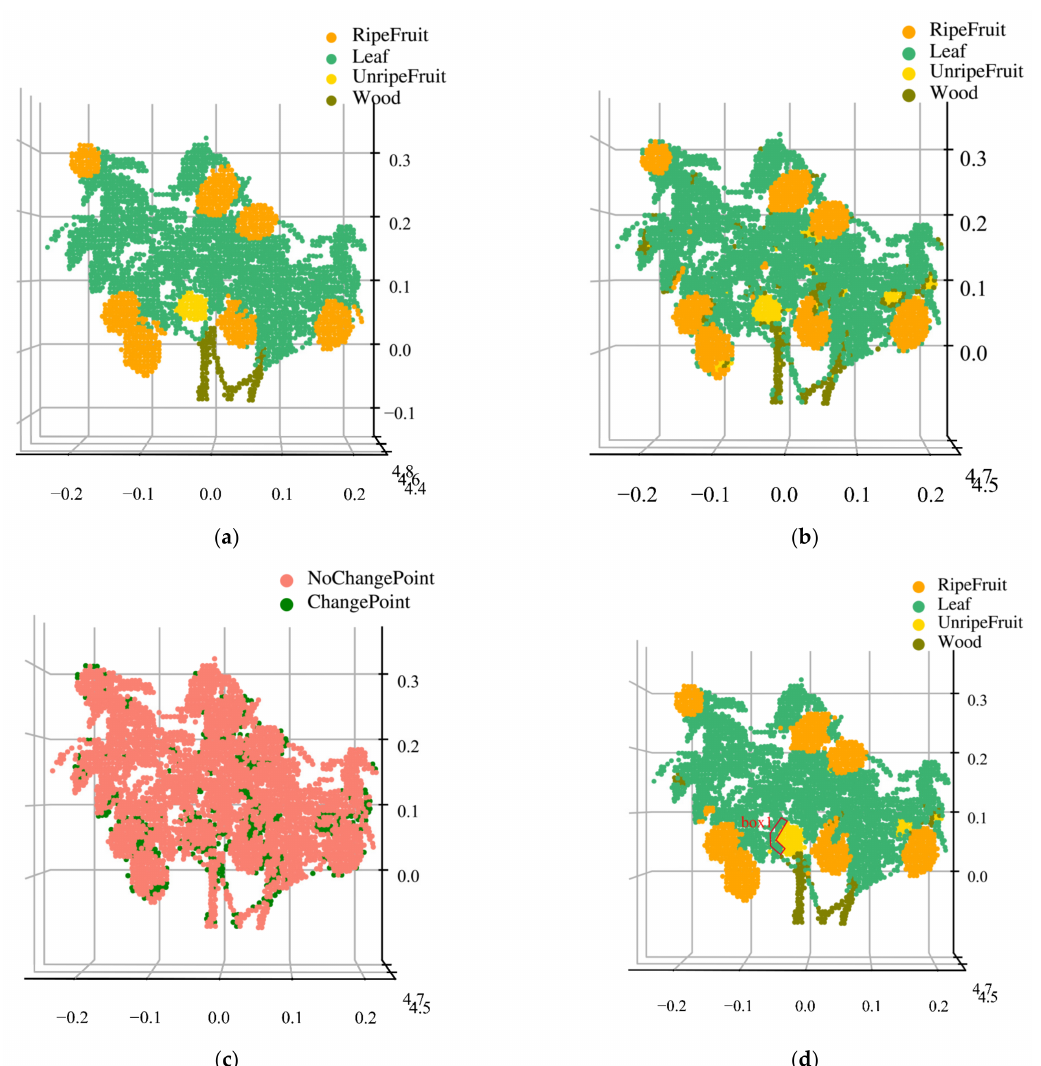
Figure 10. Reconstructed diagram of different algorithms for the classification of lemons. ( a ) Reconstruction of the real classification; ( b ) reconstruction of the preliminary classification; ( c ) class changes; and ( d ) reconstruction based on the proposed method